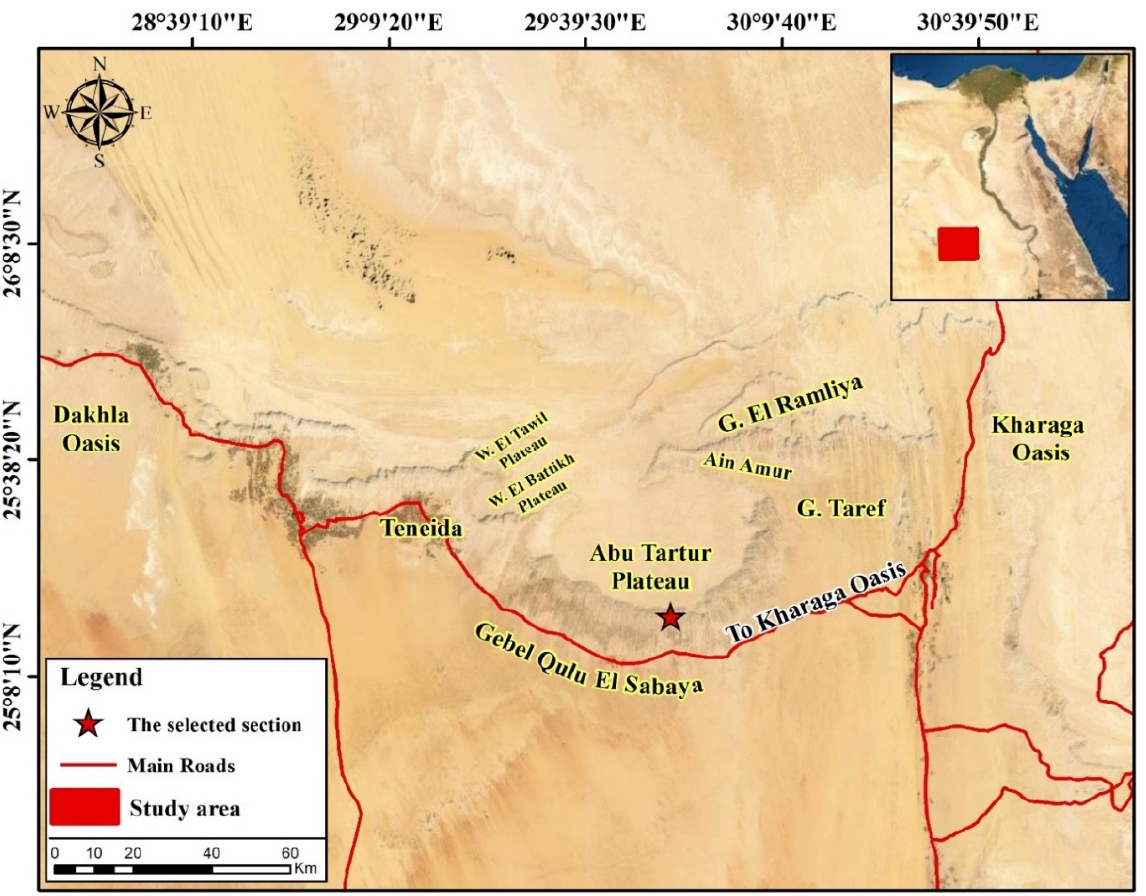
Figure 1. Location map of the studied Gebel Qulu El Sabaya, East Dakhla Oasis.